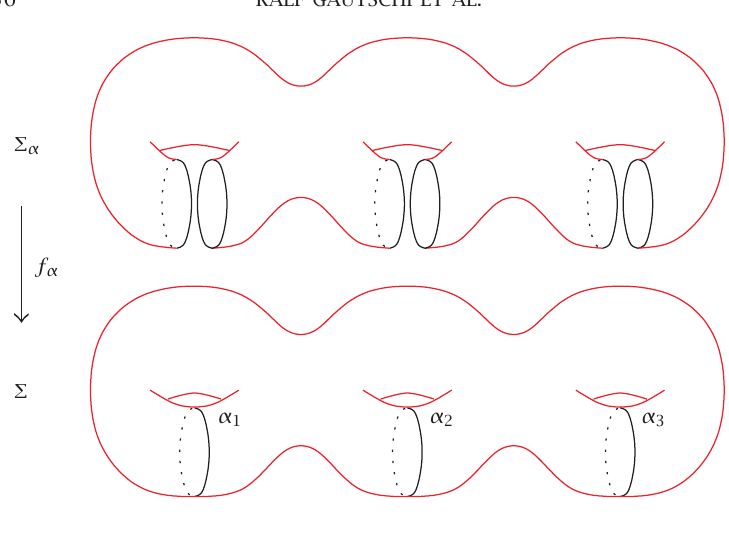
Figure A.1 . Cutting Σ along α